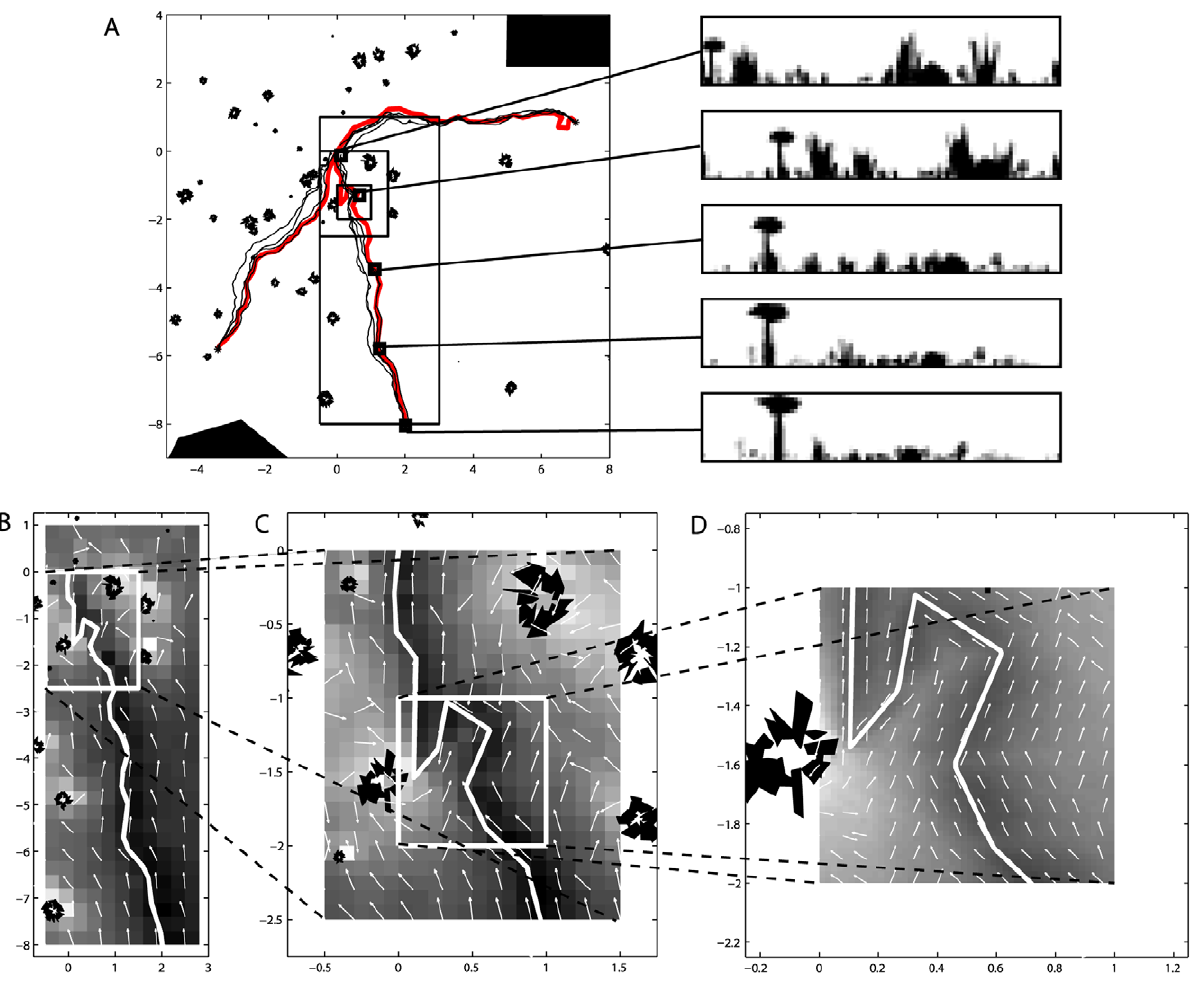
Figure 3. Navigating using a trained artificial neural network to assess scene familiarity. A) Successful return paths for three different routes. The panels to the right of the main figure show example views from points (indicated by squares) along the training route. B,C,D) Various sections of the middle route at a variety of different scales. The pseudocolour plots indicate the familiarity of the best view as was output from the trained network, with darker hues indicating increased familiarity. Conventions as in Figure 1.